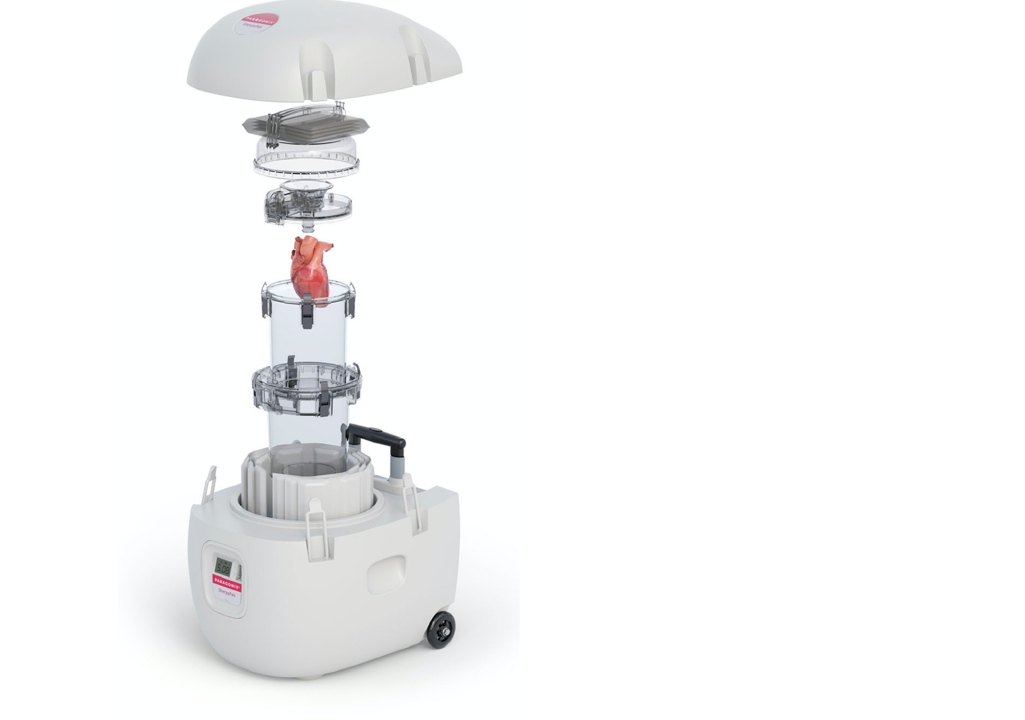
Figure 1. The Paragonix SherpaPak Cardiac Transport System. The heart is submerged in cold cardioplegia solution. The transport system uses proprietary phase change cold packs to maintain temperatures 4–8 ◦ C. Photo used with permission from Paragonix Technologies Inc.